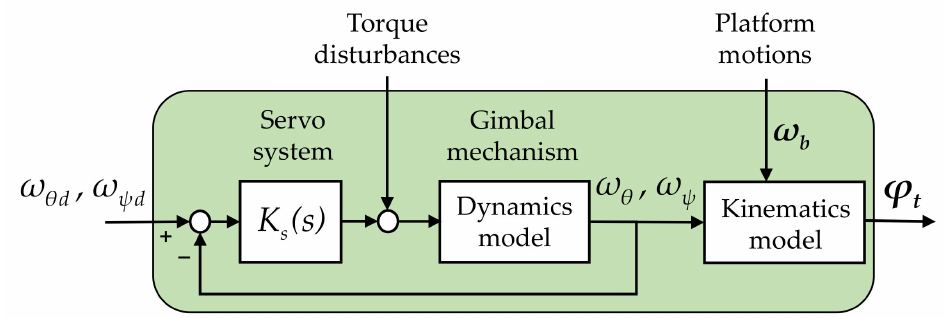
Figure 2. Block diagram of the gimbal with the stabilization